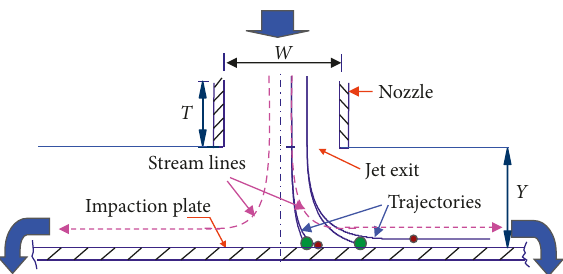
Figure 1: T-junction inertial impactor model ( W stands for the inlet nozzle diameter, T stands for the inlet nozzle height, and Y stands for the outlet diameter).